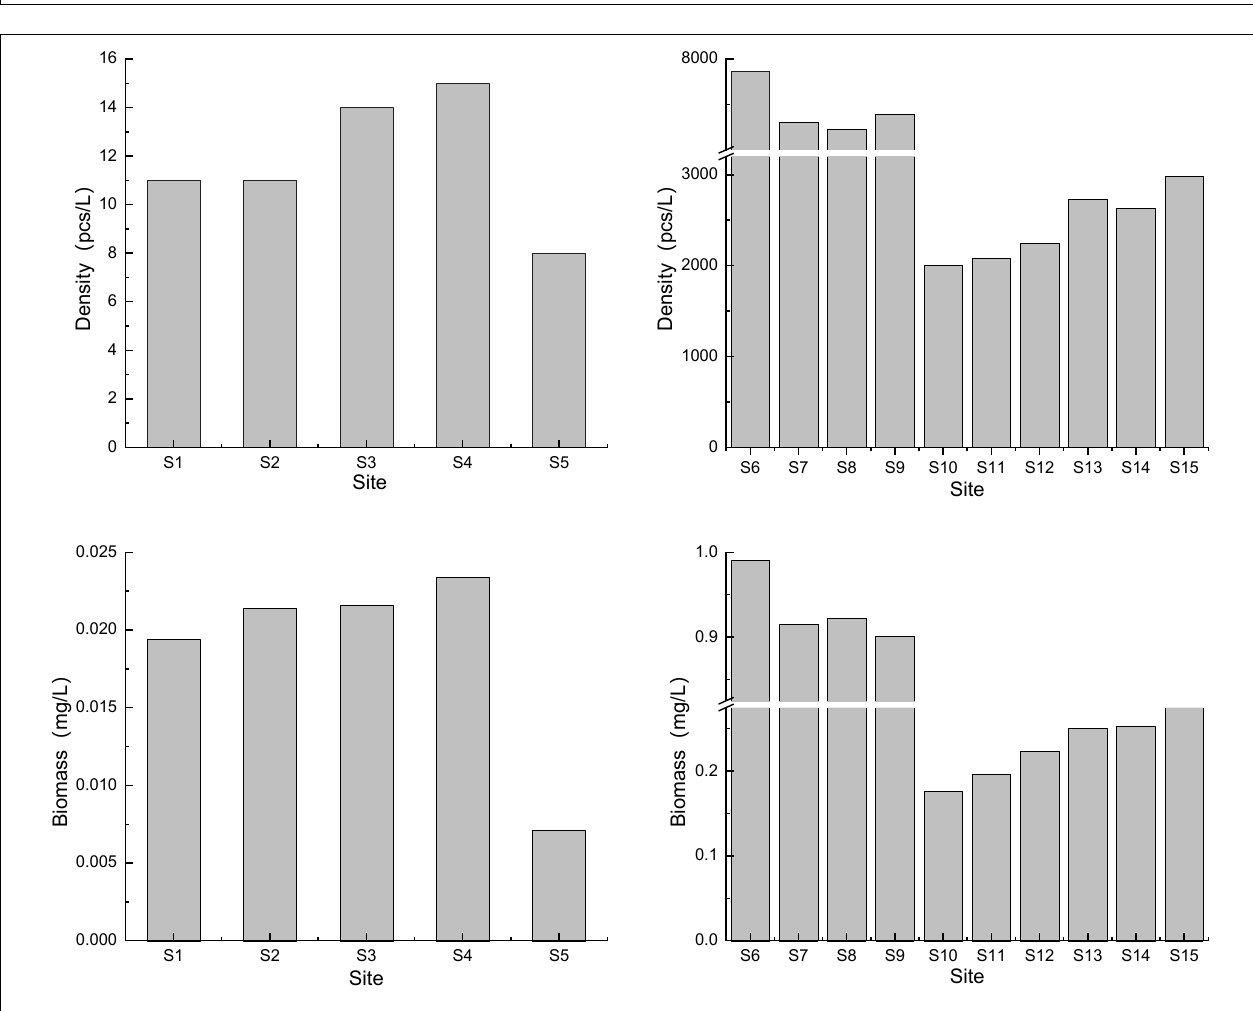
FIGURE 3 | The proportion of phytoplankton in the divisions of Bacillariophyta, Cyanophyta, and Chlorophyta in the four watersheds.